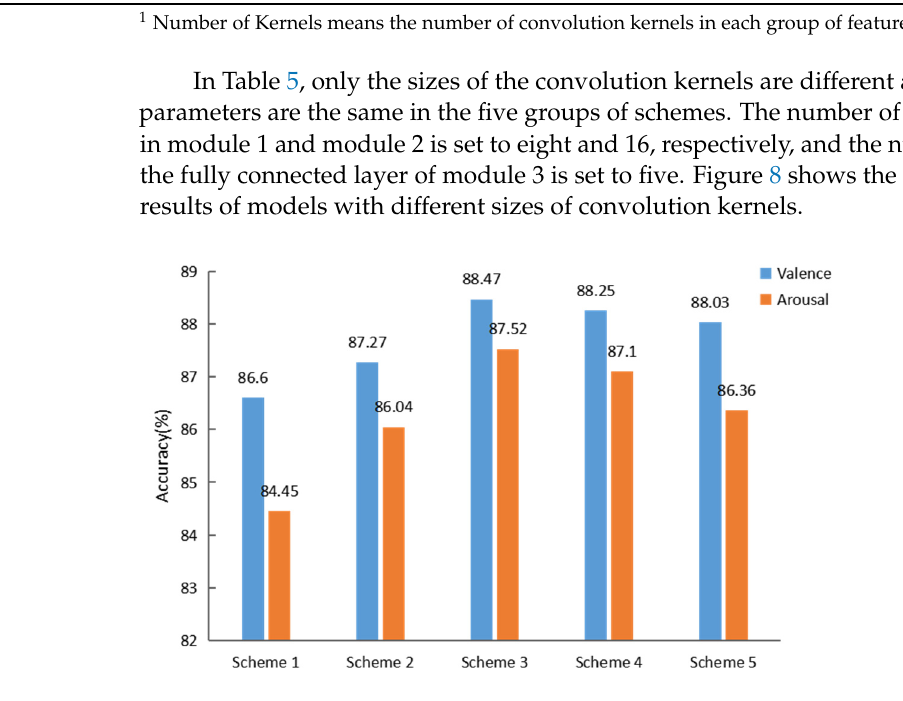
Figure 8. Performance comparison of models with different sizes of convolution kernels.